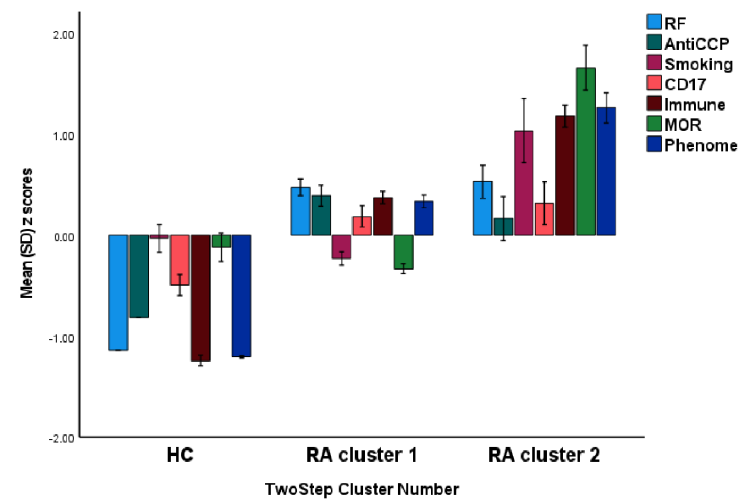
Figure 5. Results of cluster analysis performed to detect new endophenotype classes. Bar graph showing the z scores of the model features. RF: rheumatoid factor, smoking: tobacco use disorder, MOR: mu opioid receptor.